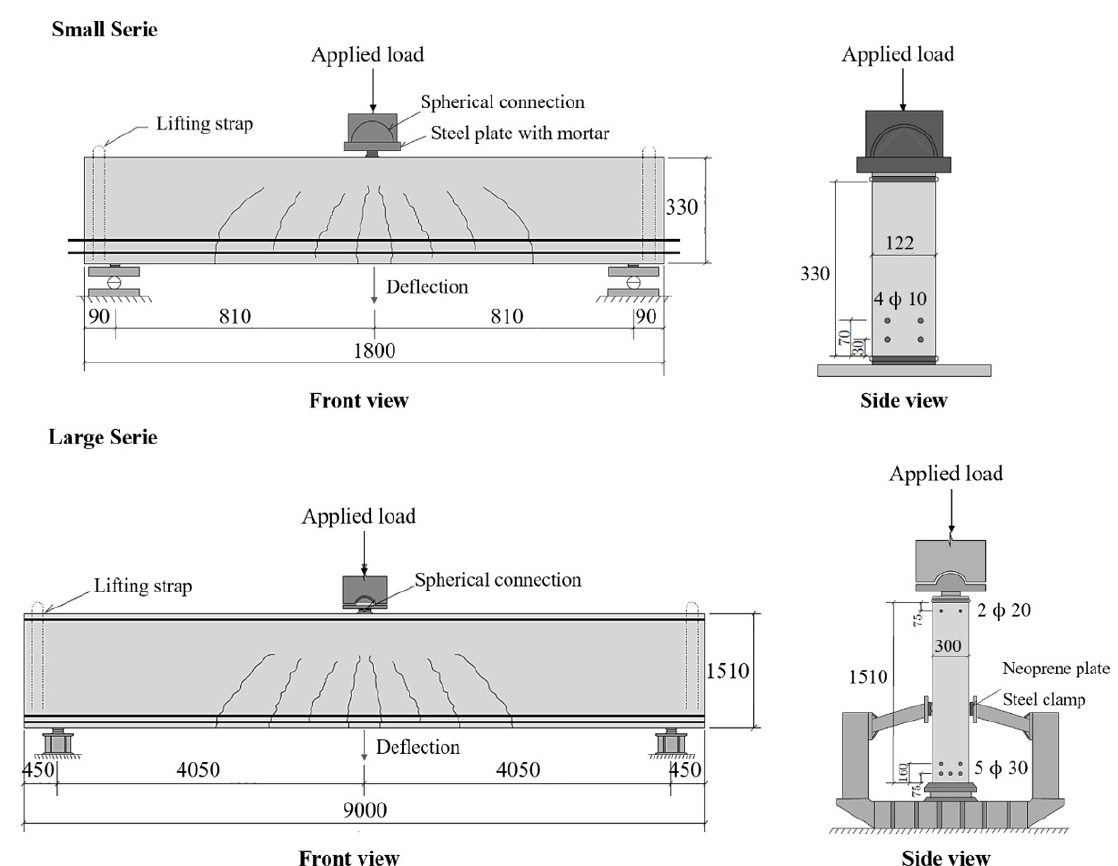
Figure 2. Beams of S-Series and L-Series of the experimental program (units in mm). Adapted by Sherwood